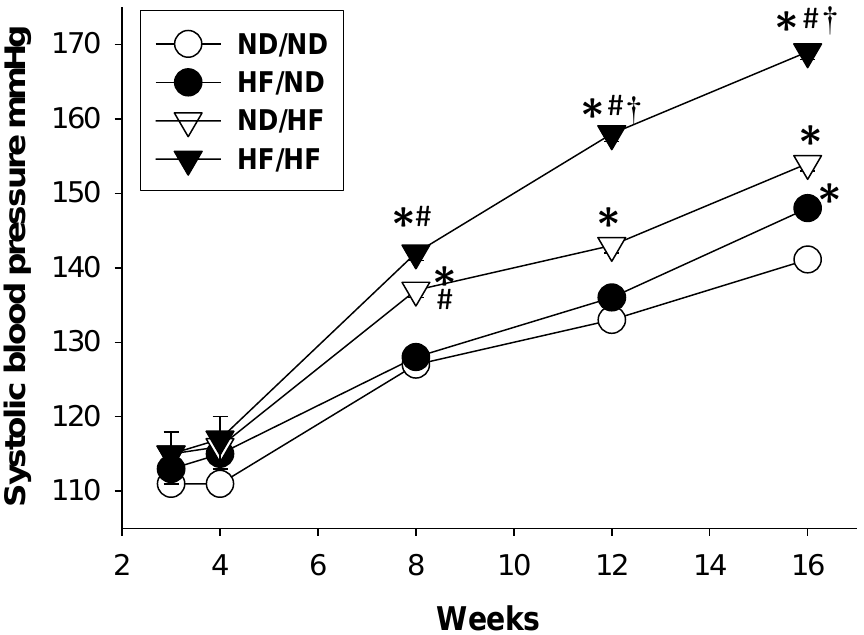
Figure 1. Effects of maternal and postnatal high-fat (HF) diet on systolic blood pressure in male offspring from 3 to 16 weeks. ND/ND, maternal plus post-weaning normal diet; HF/ND, maternal high-fat diet plus post-weaning normal diet; ND/HF, maternal normal diet plus post-weaning high-fat diet; HF/HF, maternal plus post-weaning high-fat diet. * p < 0.05 vs. ND/ND; # p < 0.05 vs. HF/ND; † p < 0.05 vs. ND/HF.